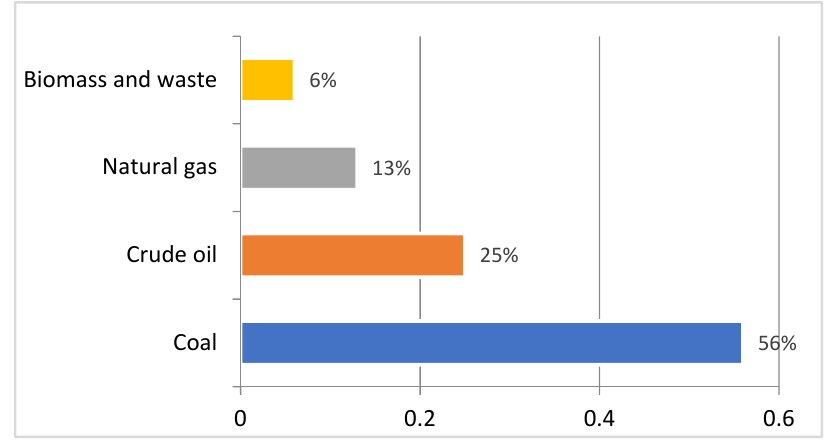
Figure 2. The structure of primary energy demand is classified. Source: author’s study based on report “Raport sektorowy—energetyka”, by Jan Sekuła posted 31 October 2021, https://profit-journal.pl/raport-sektorowy-energetyka/ access date: 2 February 2022 [60]; bankier.pl [37] (accessed on 23 November 2021).